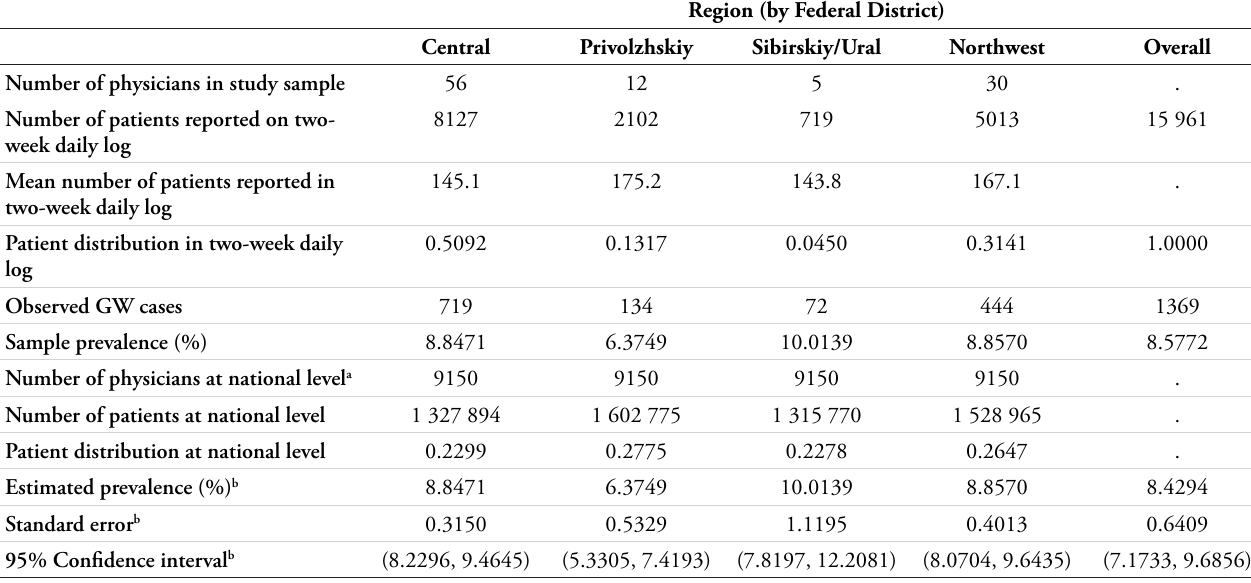
Table 2. GW Prevalence for All Patients Age 18–60 Years by Region (Participating Physicians for Two-Week Daily Log)